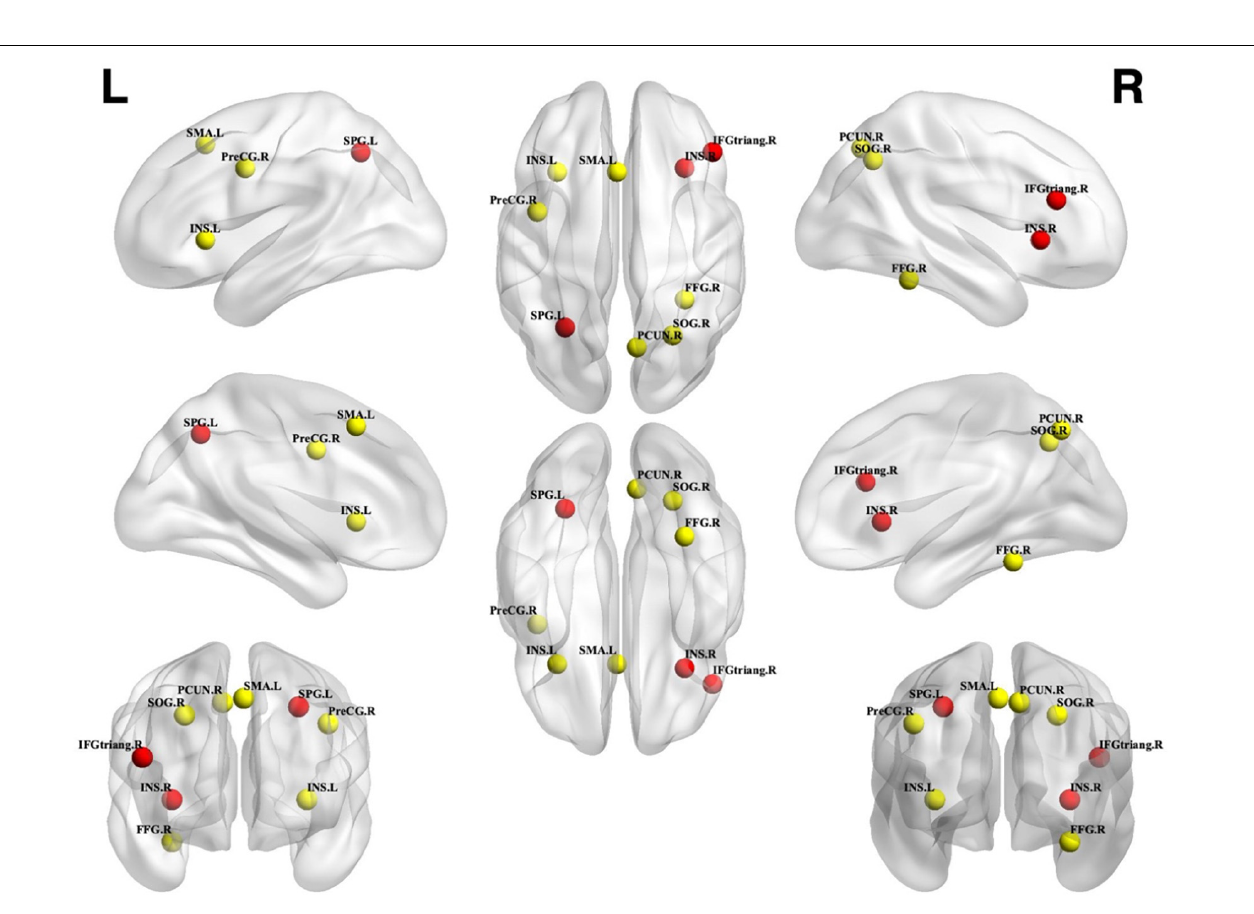
Frontiers in Neuroscience |